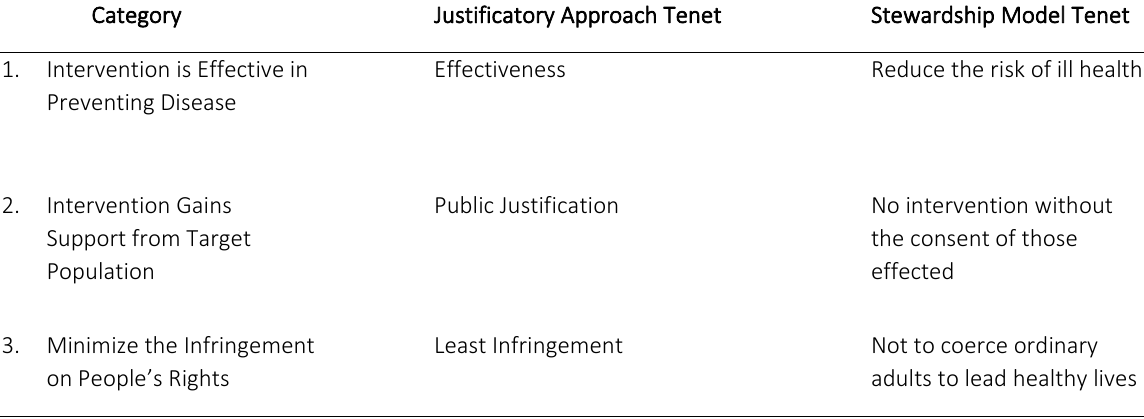
Table 1. Description of the justificatory approach and stewardship model tenets. Both of the frameworks have a number of key